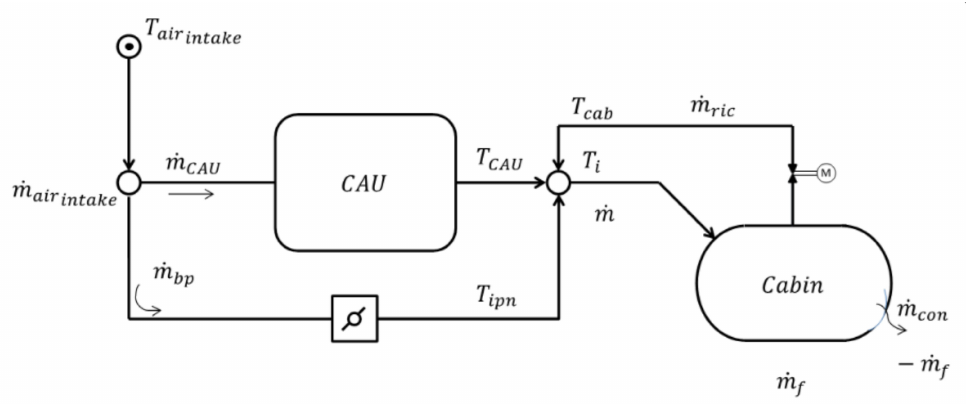
Figure 7. Bootstrap sub-freezing CAU in two different modes of operations: the cold case and the hot